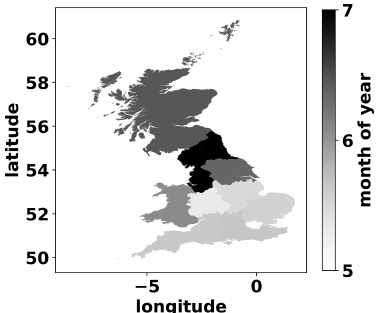
Figure A4. Mean month of year of first simulated grass cutting per GB region.